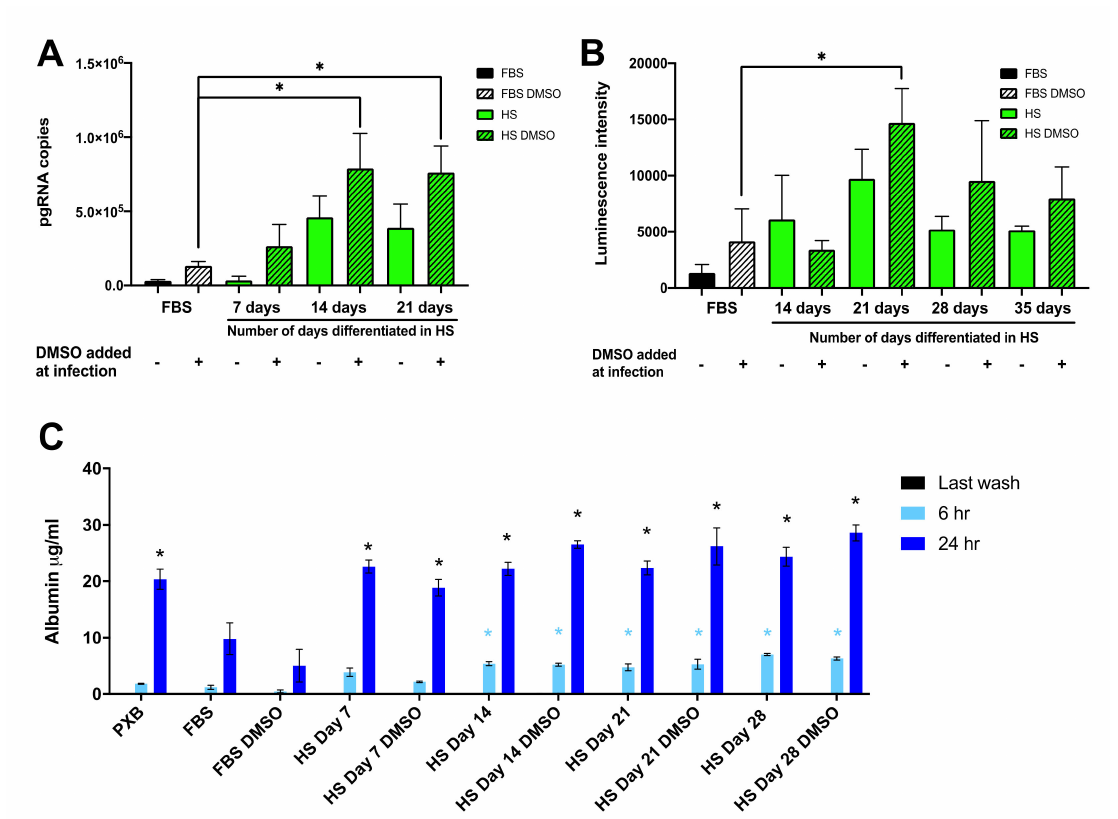
Figure 4. Enhancement of HBV replication and expression of hepatocyte markers in Huh7.5-NTCP cells cultured in human serum. ( A – C ) Huh7.5-NTCP cells were cultured for various lengths of time in a medium supplemented with FBS or HS. Cells maintained in HS-supplemented media were infected after the indicated number of days in HS-containing media. During HBV infection, DMSO was either absent ( − ) or present (+). Samples were collected on day 14 post-infection for ( A ) RT-qPCR analysis of pgRNA or ( B ) nanoluciferase reporter luminescence analysis. ( A , B ) One-way analysis of variance (ANOVA) was used with the Bonferroni correction for multiple comparison test. * p < 0.05. ( C ) Secreted human albumin concentration after 6 h and 24 h was determined using ELISA. Average values ( ± SD) derived from three experiments are plotted. Two-way analysis of variance (ANOVA) was used with the Bonferroni correction for multiple comparison test. Blue *, p < 0.01 compared to FBS albumin secretion in 6 h. Black *, p < 0.01 compared to FBS albumin secretion in 24